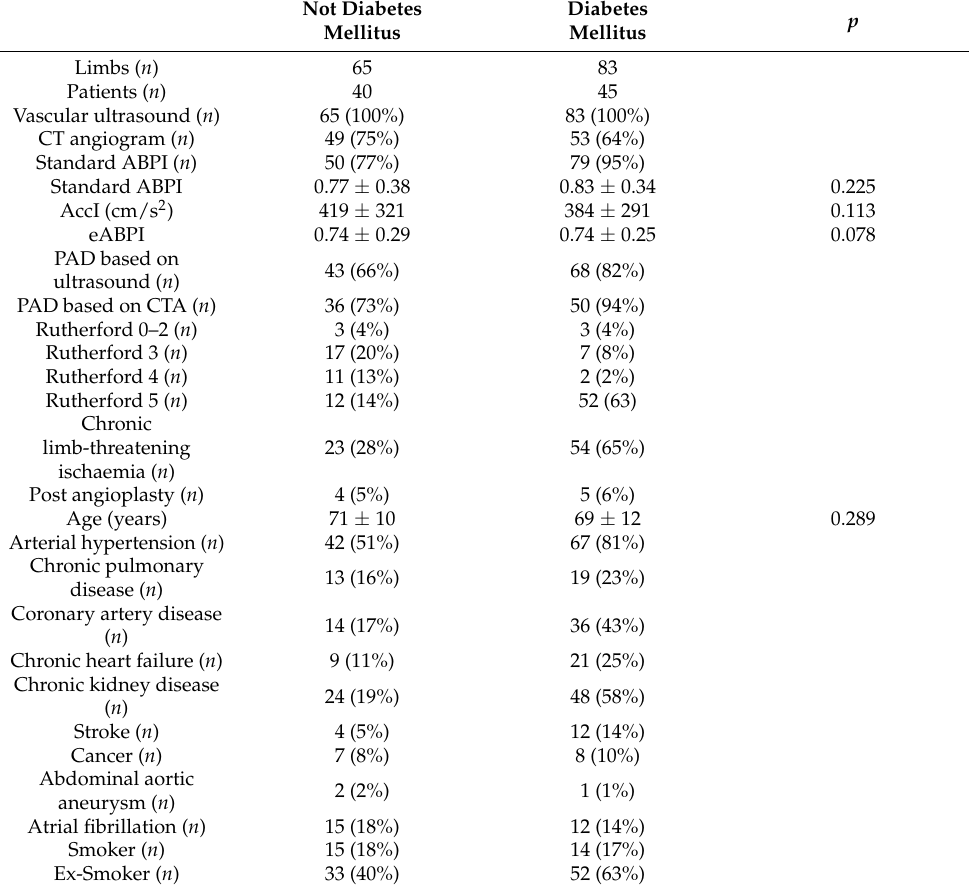
Table 2. Characteristics of patients with and without diabetes mellitus. (mean ± standard deviation, independent t -test, Characteristics are described according to limbs; ABPI = ankle brachial pressure index, eABPI = estimated ankle brachial pressure index AccI = Acceleration Index, CT = computed tomography, eABPI = estimated ankle brachial pressure index, PAD = peripheral artery